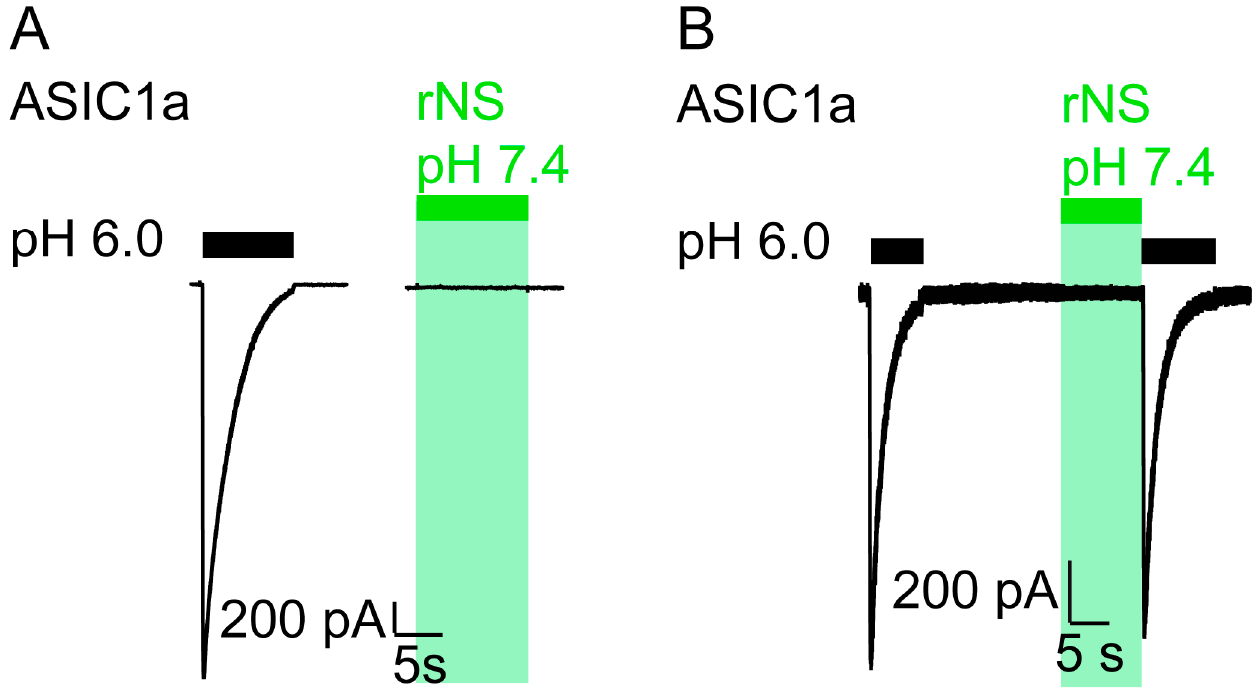
Figure 2. Nocistatin does not activate ASIC1a in CHO cells. ( A ) current trace of a CHO cell transfected with rASIC1a cDNA stimulated with pH 6.0 (black bar) or with rNS (0.25 mM, pH 7.4, green bar) for 10 s. Conditioning pH 7.4. This trace is representative for 6 similar measurements. ( B ) as in A, ASIC1a-expressing CHO cell was stimulated repetitively with pH 6.0 for 10 s (black bars). rNS (0.25 mM, pH 7.4, green bar) was applied for 10 s prior to pH 6.0 stimulation. This trace is representative for 3 similar